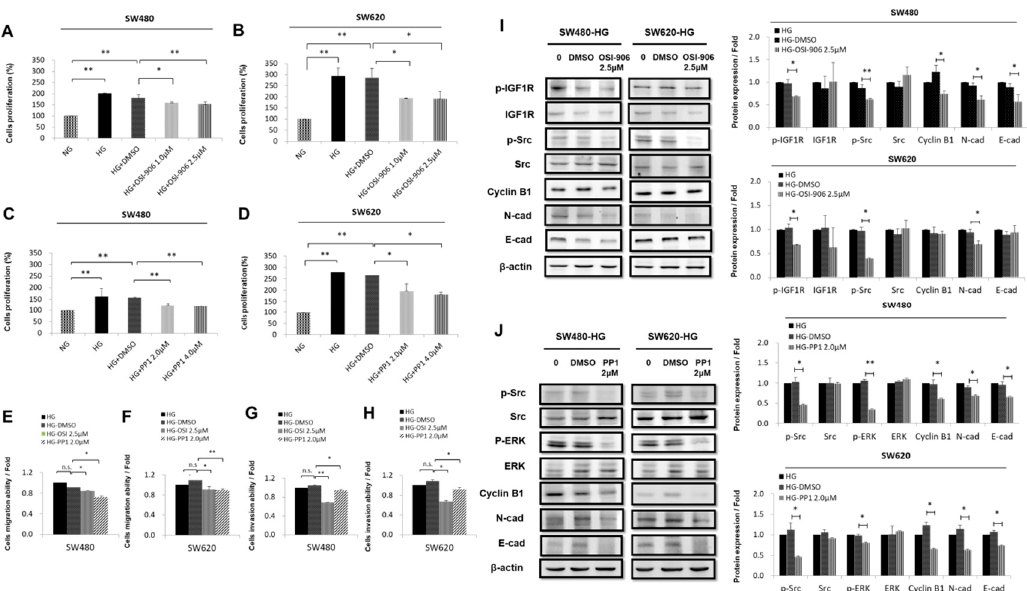
Figure 3. High glucose (HG) concentrations regulated IGF1R and Src and promoted the downstream signaling pathway in colorectal cancer (CRC) cells. ( A , B ) OSI-906 (IGF1R inhibitor) or ( C , D ) PP1 (Src inhibitor) affected proliferation in a dose-dependent manner in CRC cells. First, 3.5 × 10 5 SW480 and SW620 cells were seeded onto a 24-well plate. After incubation overnight, they were treated with OSI-906 (1.0 µ M and 2.5 µ M) or PP1 (2.0 µ M and 4.0 µ M). These data show that OSI-906 and PP1 significantly inhibited proliferation induced by HG concentration in SW480 and SW620 cells at 1.0 µ M and 2.5 µ M doses or 2.0 µ M and 4.0 µ M doses compared with the control group (dimethyl sulfoxide, DMSO). ( E – H ) Metastatic activities of CRC cells treated with OSI-906 or PP1 were detected using a Transwell assay; 3.5 × 10 5 SW480 and SW620 cells were plated onto a 24-well plate and incubated overnight after treatment with OSI-906 2.5 µ M or PP1 2.0 µ M for 96 h. These data show that OSI-906 (2.5 µ M) and PP1 (2 µ M) significantly inhibited the migration viability of SW480 and SW620 cells, which was promoted by HG concentration, compared with the HG-concentration group evaluated as positive controls. In addition, 3.5 × 10 5 SW480 or SW620 cells were cultured in basement membrane matrix-coated 24-well plates with HG-concentration medium and then treated with OSI-906 or PP1 for 168 h. These data show that OSI-906 and PP1 significantly inhibited the invasion viability of SW480 and SW620 cells. ( I , J ) Western blot analysis data suggest that OSI-906 or PP1 treatment reduced p-IGF1R or p-Src downstream signaling, reduced the expression of cell-cycle-regulated proteins, and induced and reduced expression of epithelial-to-mesenchymal transition proteins in HG-concentration medium compared with the control group (DMSO). HG concentration was evaluated as a positive control and levels of β -actin were evaluated as loading controls. These data are expressed as mean ± SEM and are representative of two independent experiments according to Student’s t -tests; * p < 0.05, ** p < 0.005; n.s. =